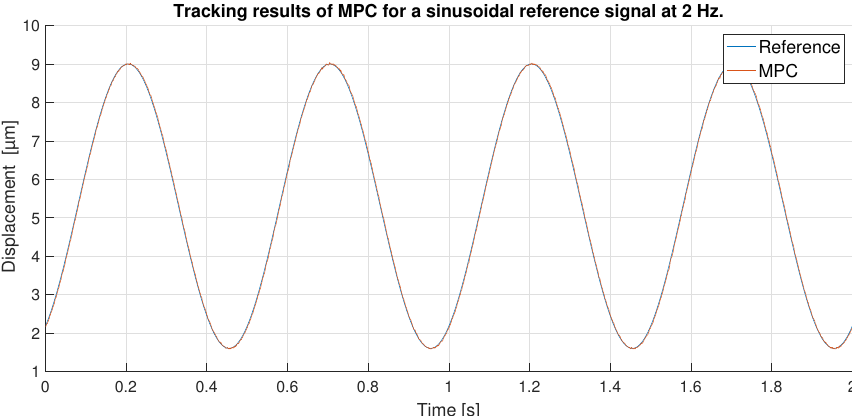
Figure 26. Tracking results of the MPC for a 2 Hz sinusoidal reference of reduced